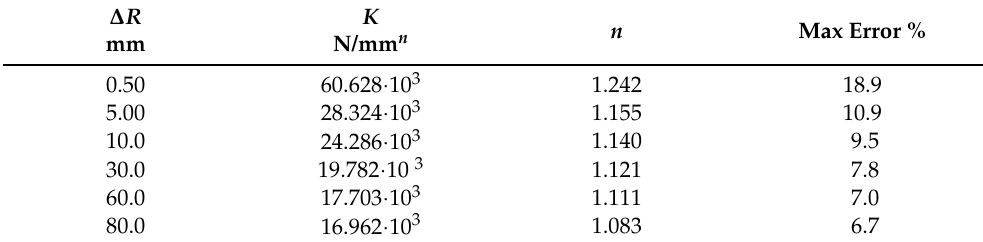
Table 5. Polynomial version of Johnson’s [24] force model (Aluminum).